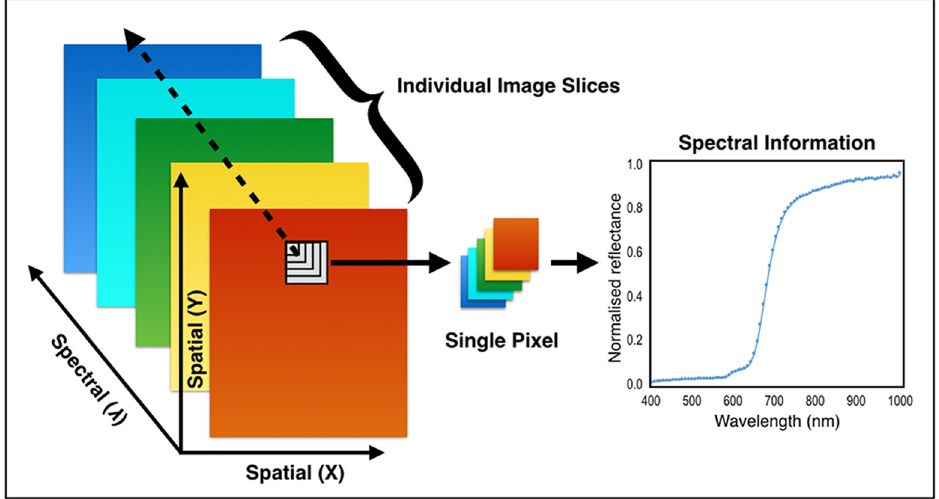
Figure 1. Hyperspectral image representation.